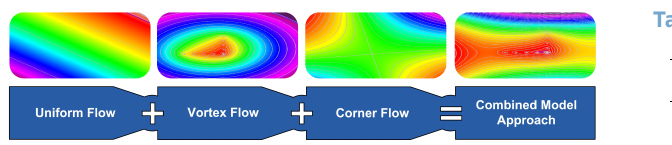
Figure 1. Basic functions and combined modell approach.